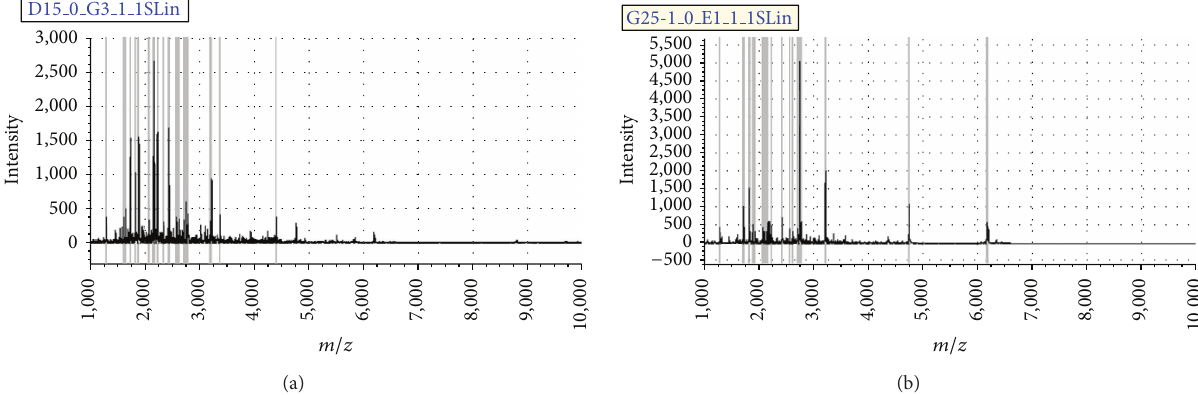
Figure 1: Typical urinary sample mass spectrum from MALDI-TOF MS after being purified by weak cation exchange magnetic beads. (a) From one sample of type 2 diabetic patients without coronary artery disease. (b) From one sample of type 2 diabetic patients with coronary artery disease.